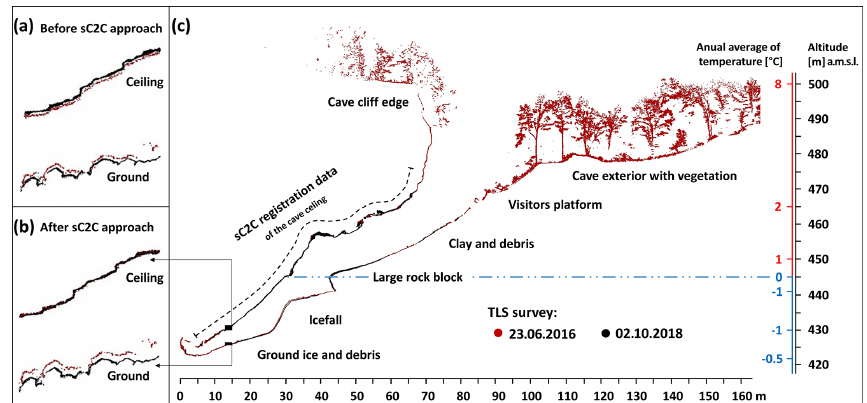
Figure 7. Demonstration of the improved registration accuracy by the sC2C method. Red dots represent the reference point cloud surveyed on 23 June 2016. The point cloud surveyed on 2 October 2018 marked with black dots was used to demonstrate the registration result using the proposed sC2C approach. The results of registering the two scan missions in the detailed views show the performance of (a) the standard C2C approach and (b) after applying the sC2C approach in which stable points of the cave ceiling (c) on the bare rock were used. The size of the cave can be estimated from the vertical and horizontal axes, which are in metres. The left side of the vertical axis shows mean annual air temperature inside the cave based on our temperature data loggers. The mean temperature is the lowest in the area of the icefall. The mean annual temperature of 0 ◦ C is just above the icefall, indicating the approximate maximal vertical range of the cave floor